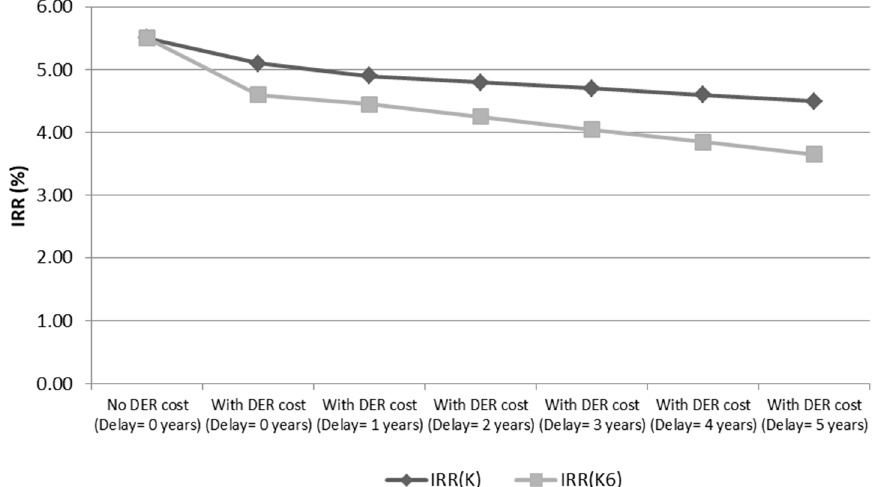
Figure 10. Investment return analysis for transformation enlargement K and K6.